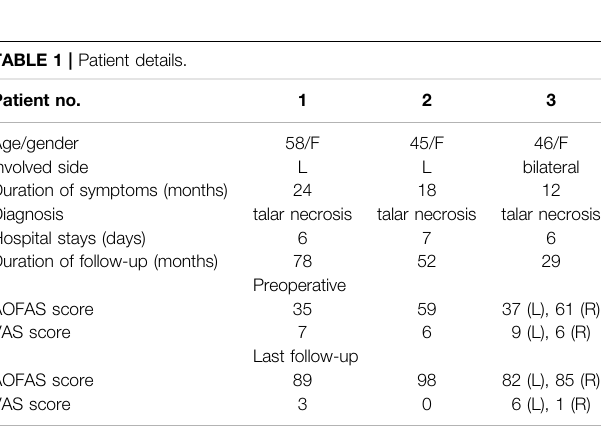
TABLE 1 | Patient details. Patient